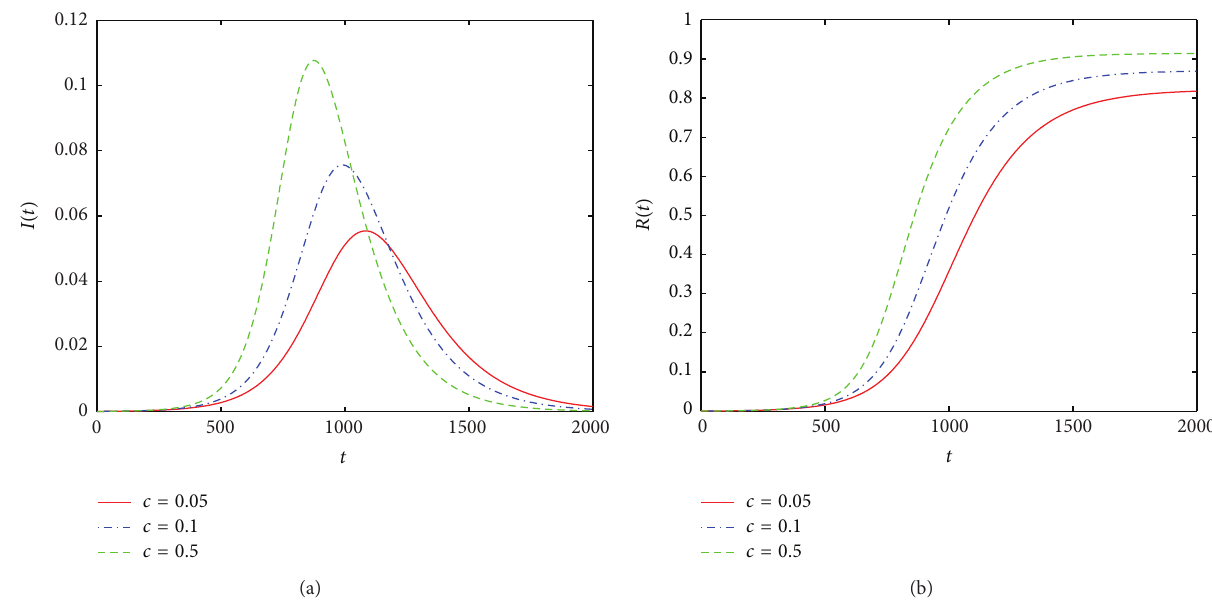
Figure 5: Density of spreaders and stiflers on regular